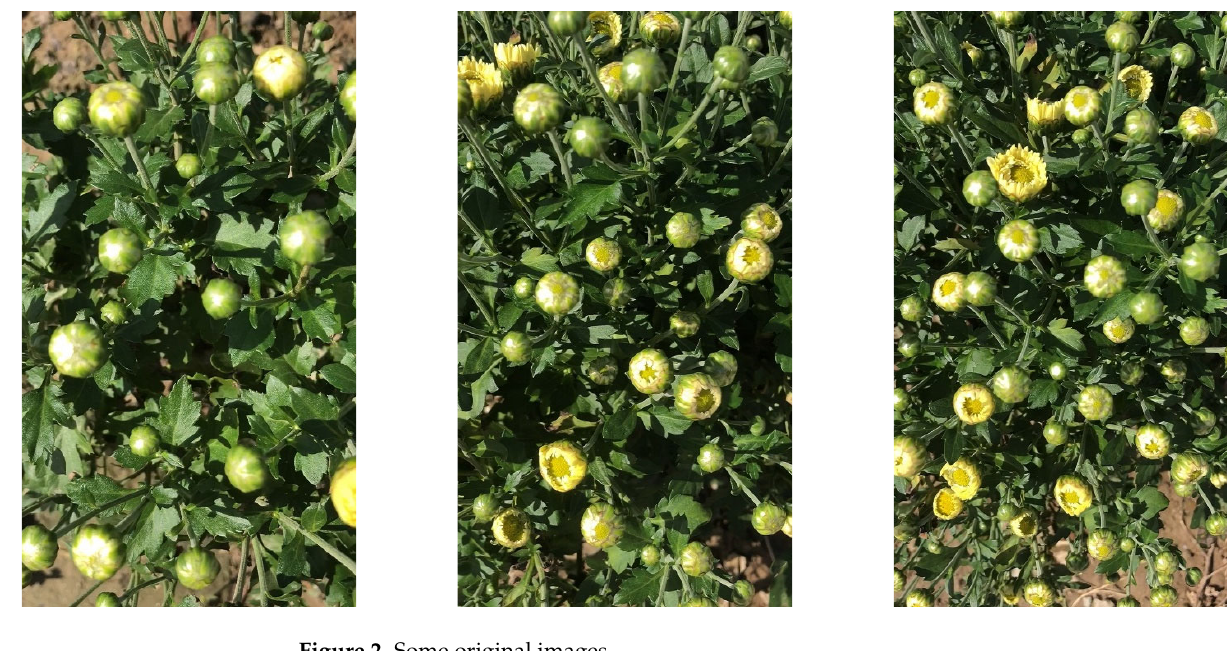
Figure 2. Some original images.